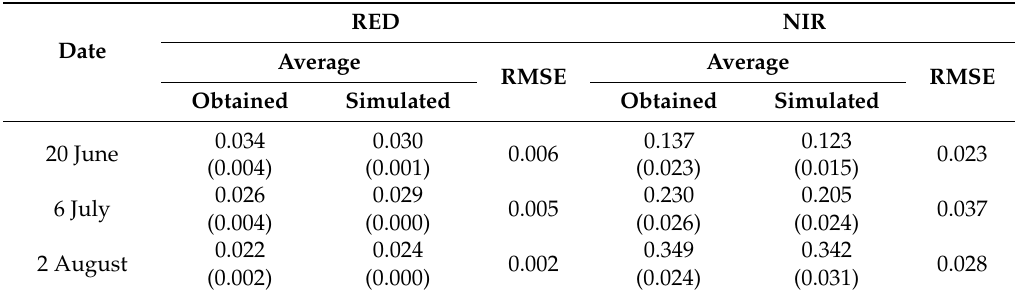
Table 2. Average reflectance at measurement points (n = 80) obtained from the reflectance image and simulated by FLiES. The number in parentheses shows the standard deviation. Root mean square error (RMSE) was calculated from the di ff erence between the obtained and simulated reflectance.